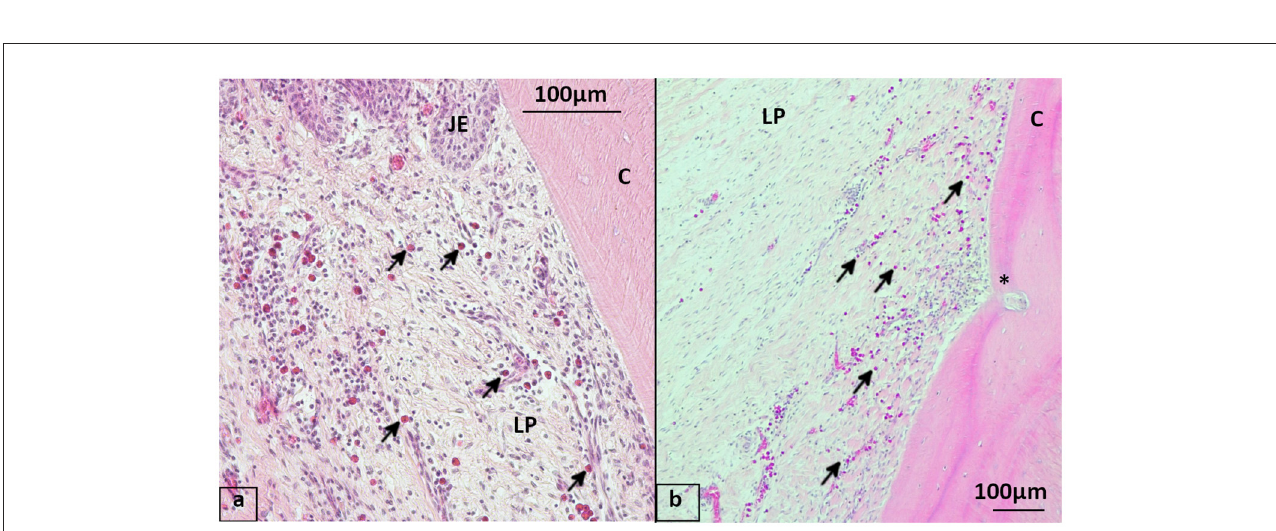
FIGURE6 Eosinophils in the gingiva, staining hematoxylin-eosin (HE) (a) 19-year-old Icelandic mare from the control group, 409 lingual aspect with mulitfocal perivascular eosinophil infiltration (arrows) of the lamina propria beneath the junctional epithelium. (b) 29-year-old Icelandic PPID mare, 408 lingual aspect showing multiple eosinophils infiltrating the lamina propria, blood vessel running into cementum ( * ). JE, Junctional epithelium; LP, Lamina propria; C, Cementum.